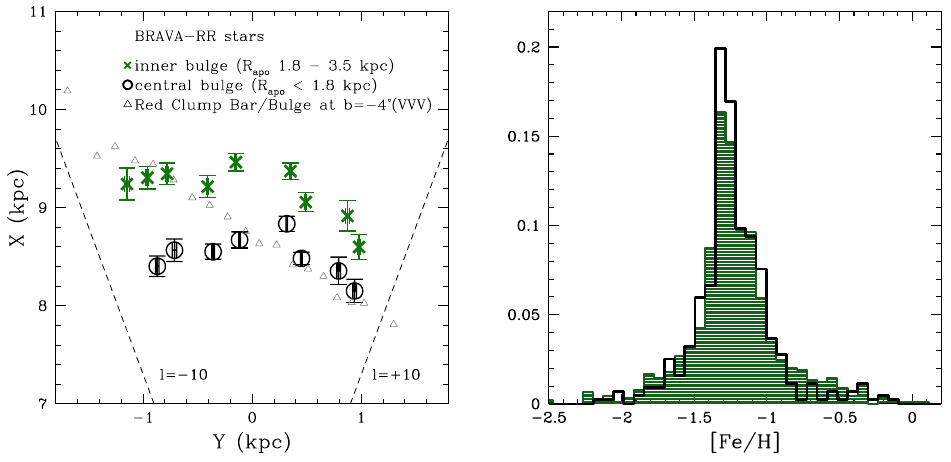
Figure 9. ( Left ) The mean spatial distribution of the most centrally concentrated RRLs ( R apo < 1.8 kpc) as compared to bulge RRLs with apocenter distances between 1.8 and 3.5 kpc. The spatial distribution of red clump stars from Gonzalez et al. (2012) that trace out the bar/bulge is also shown. ( Right ) The photometric [ Fe/H ] metallicity distribution for the RRLs in the inner bulge (green, filled histogram) as well as the RRLs in the central bulge (black, solid line histogram). There is no obvious [ Fe/H ] metallicity difference between these two RRL